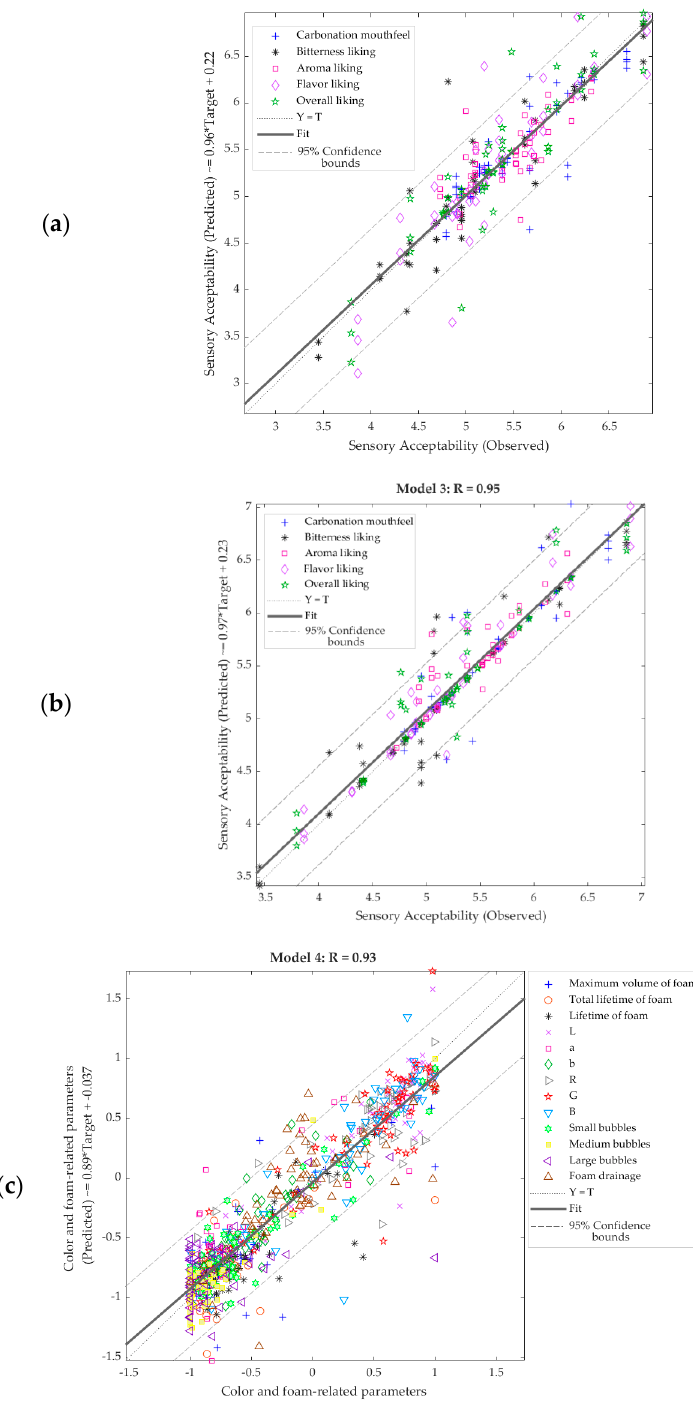
Figure 5. Overall regression models for ( a ) Model 2 to predict the consumer sensory responses using the near-infrared absorbance values as inputs, ( b ) Model 3 to predict the consumer sensory responses using the electronic nose outputs as inputs, and ( c ) Model 4 to predict the physical parameters measured with the RoboBEER using the electronic nose outputs as inputs.